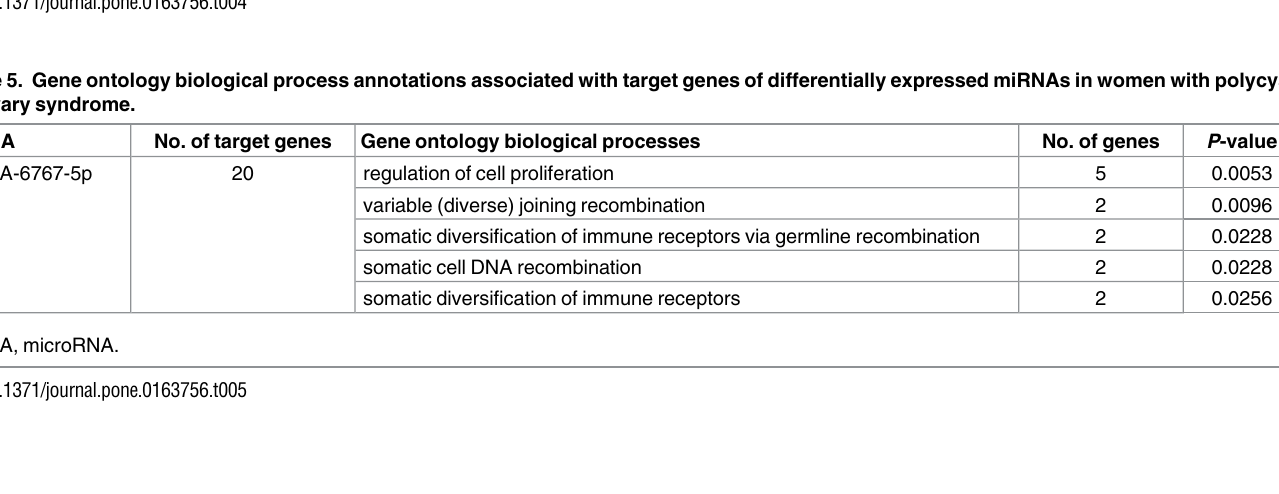
Adjusted for age and body mass index.